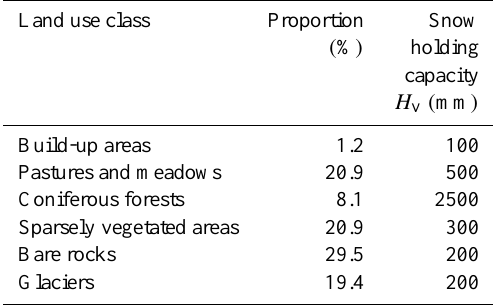
Table 1. Land use classes used in COSERO (derived from CORINE land cover data; EEA, 1995) and their proportion in the Ötztal. Snow holding capacities H v for each type of land use are taken from Liston and Sturm (1998) and Prasad et al. (2001). Land use class Proportion Snow ( % ) capacity H v ( mm )